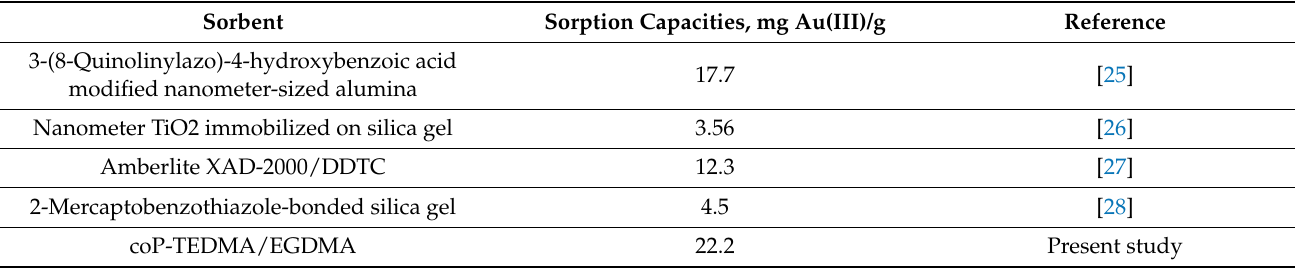
Table 5. Sorption capacities of some sorbents cited in the literature.